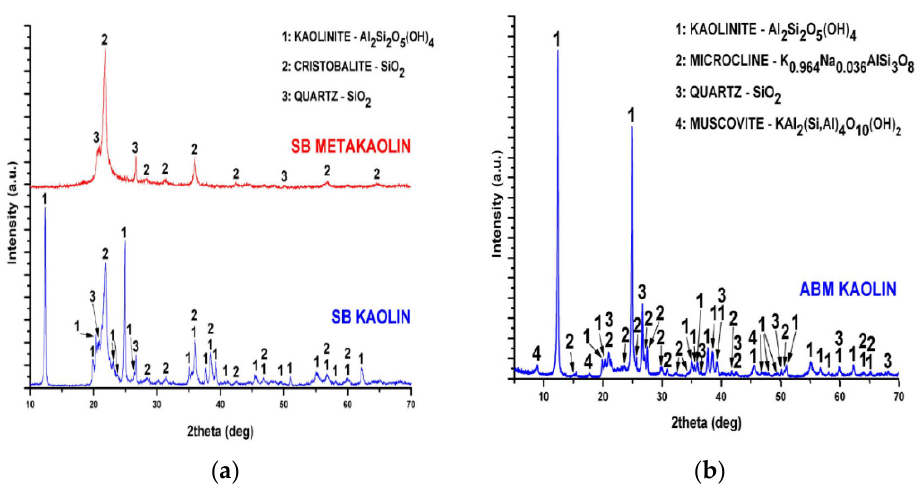
Figure 1. Powder X-ray diffractogram of ( a ) SB Kaolin and Metakaolin ( b ) and AMB Kaolin used in this study.